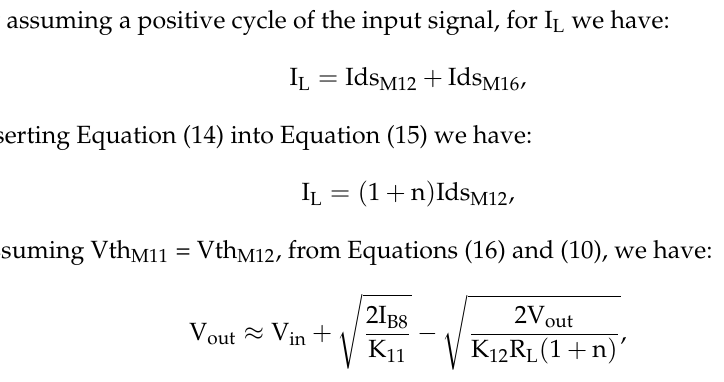
Figure 5. Proposed class AB voltage buffer with current splitting